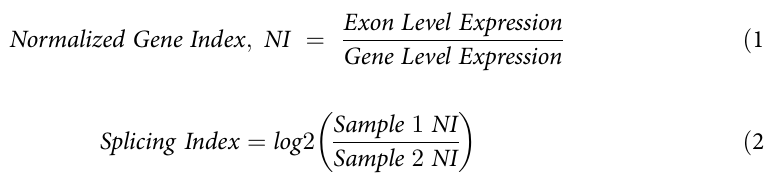
S1 Table. Comparison of up-regulated genes on the Nimblegen, Agilent HD exon, and Agi- lent 15K arrays. All genes that were up-regulated on any array are represented in column